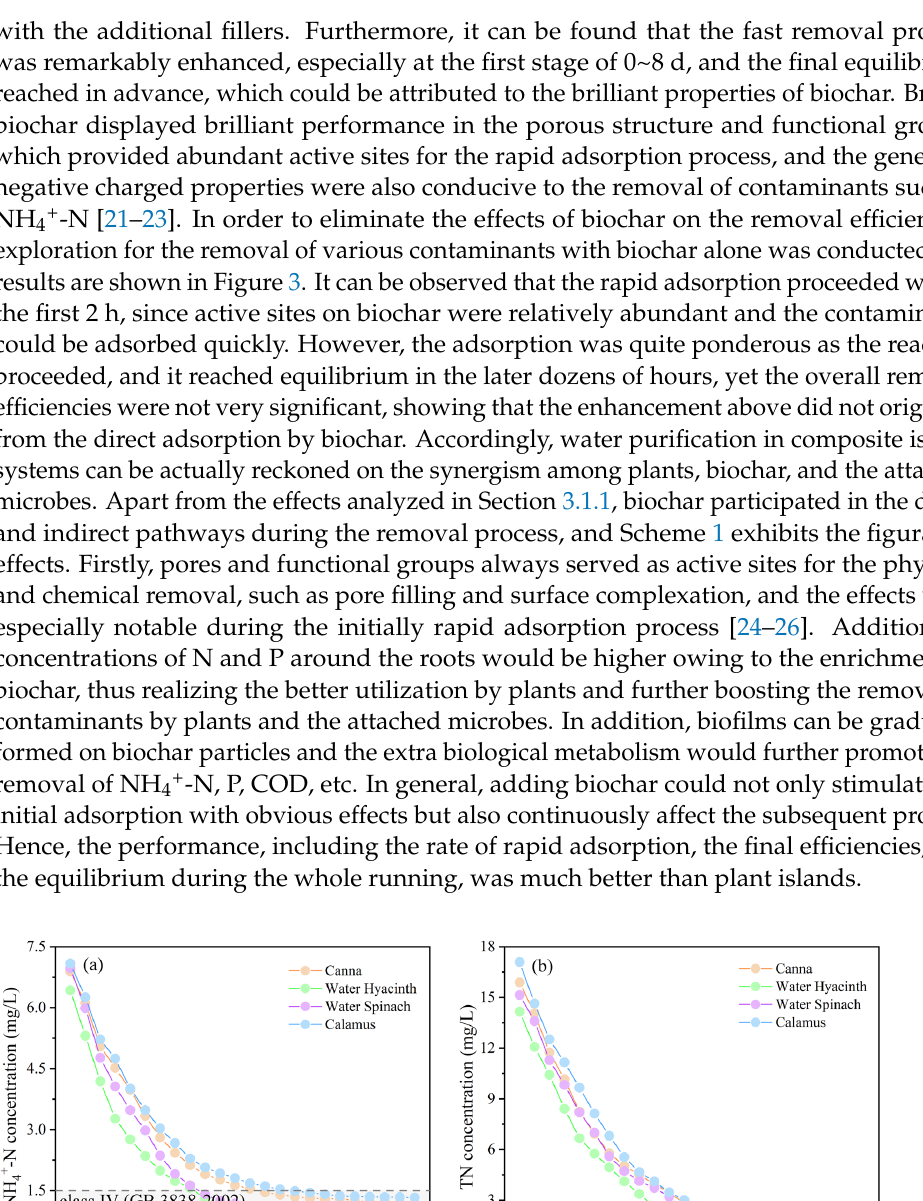
Figure 3. Removal of the contaminants with biochar alone: ( a ) TN, ( b ) TP, and ( c ) COD .